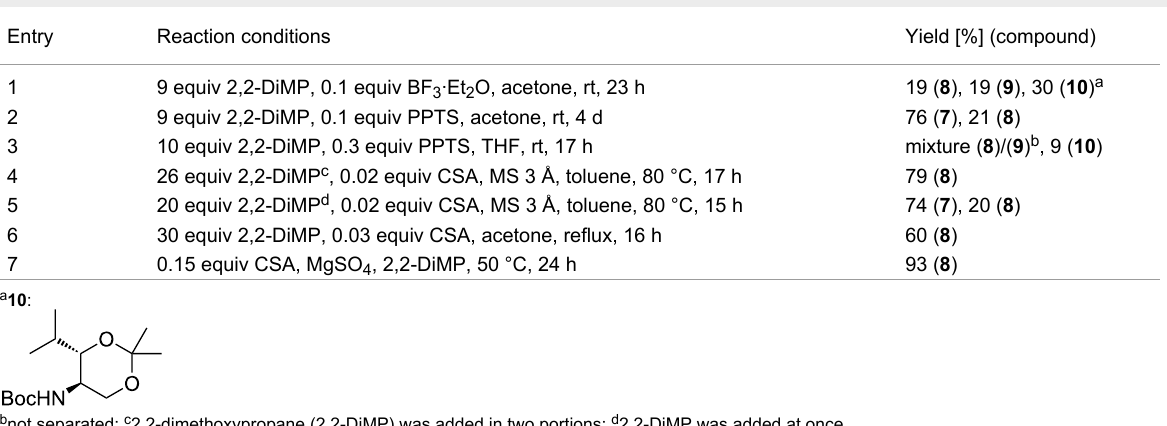
Table 1: Optimization of the reaction of 7 to dimethyloxazolidine 8